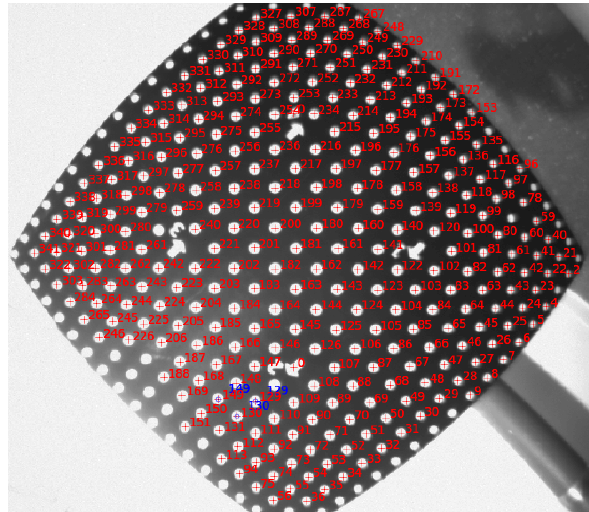
Figure 4: 2D test field imaged with a strongly distorting lens. Blue numbers were manually given as initial reference points. Red numbers were automatically found. Zero (0) indicates,